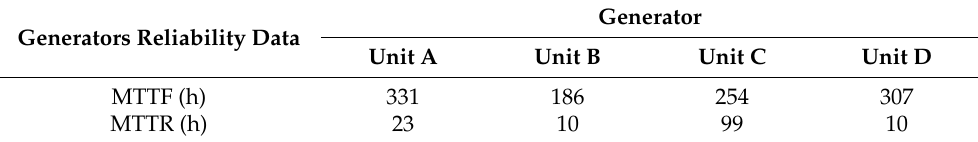
Table 2. System’s generators reliability